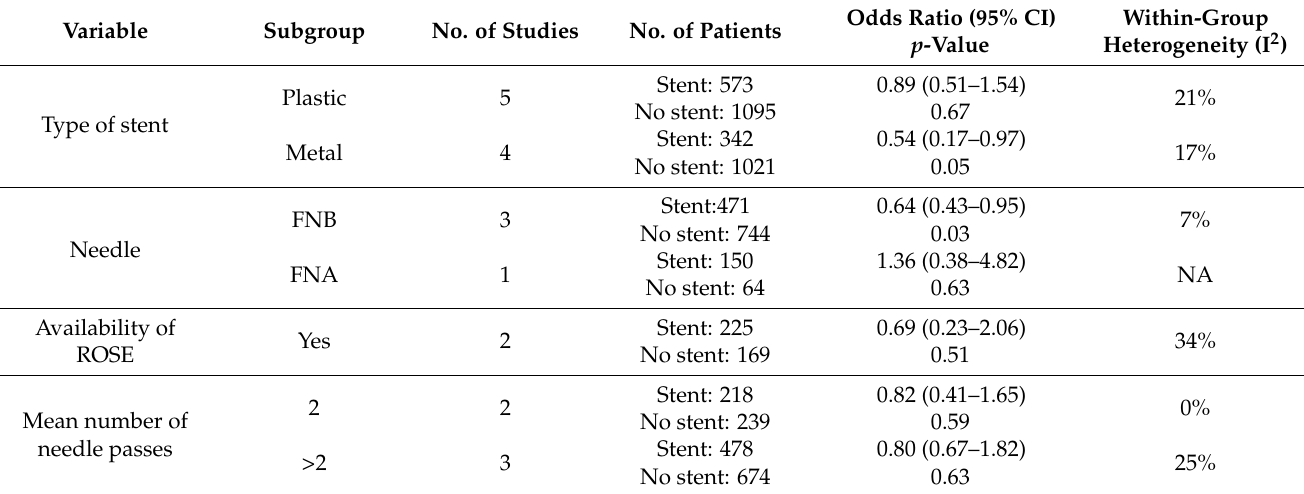
Table 2. Sensitivity analysis concerning the primary outcome (diagnostic accuracy).